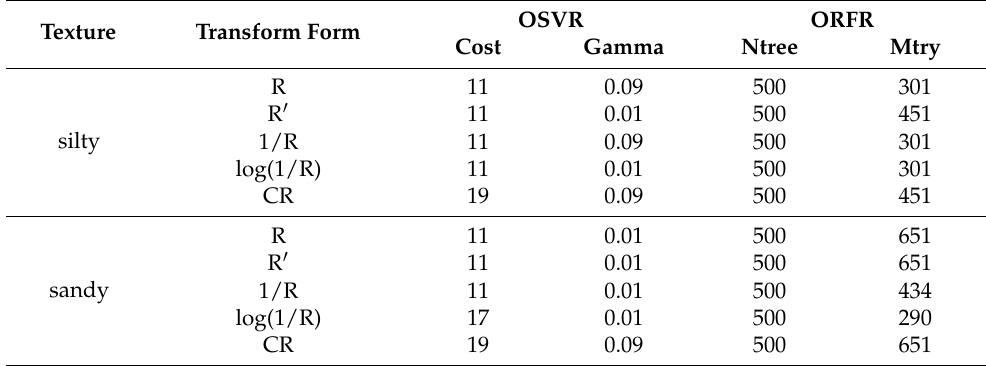
Table 3. Model optimized